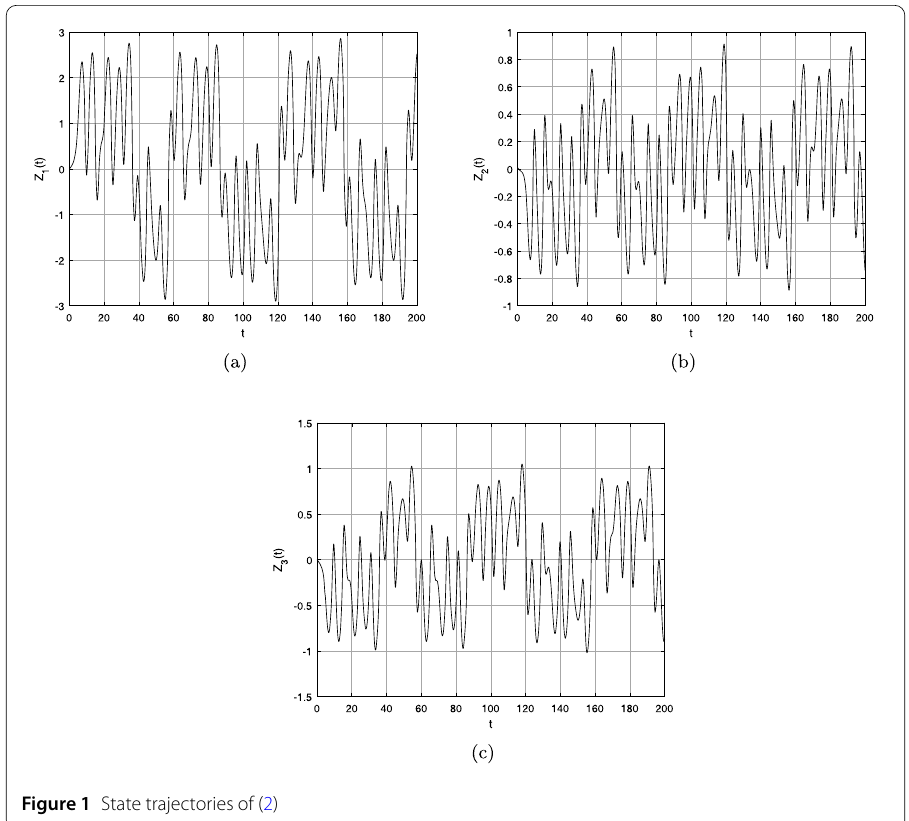
Figure 1 State trajectories of